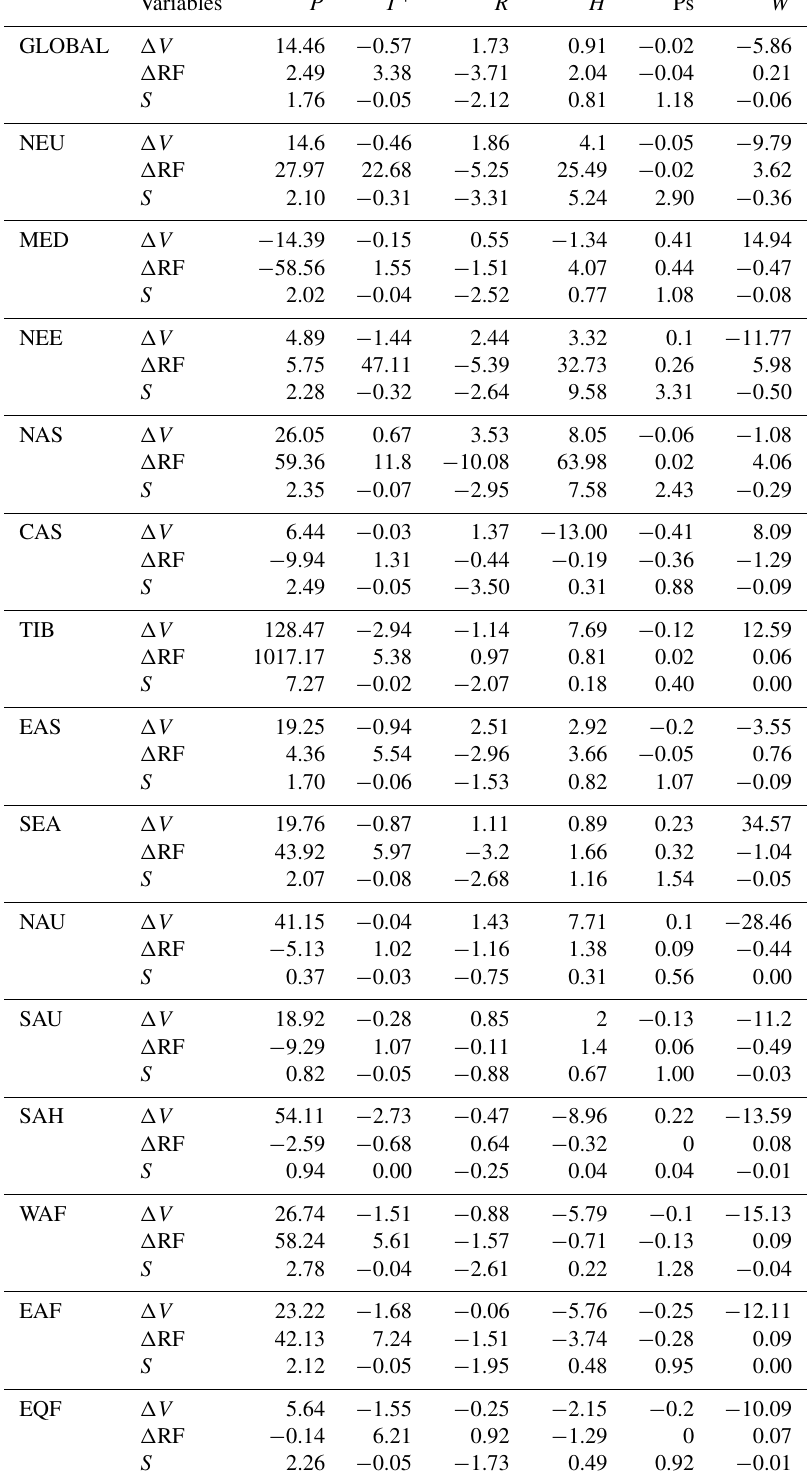
Table 4. Relative change (%) in forcing variable ( (cid:49)V ), corresponding relative change (%) in runoff ( (cid:49) RF), and sensitivities ( S = (cid:49) RF/ (cid:49)V ) per region, for each variable. For each region, the median of the (cid:49)V , (cid:49) RF, and S values of all land grid boxes is shown.